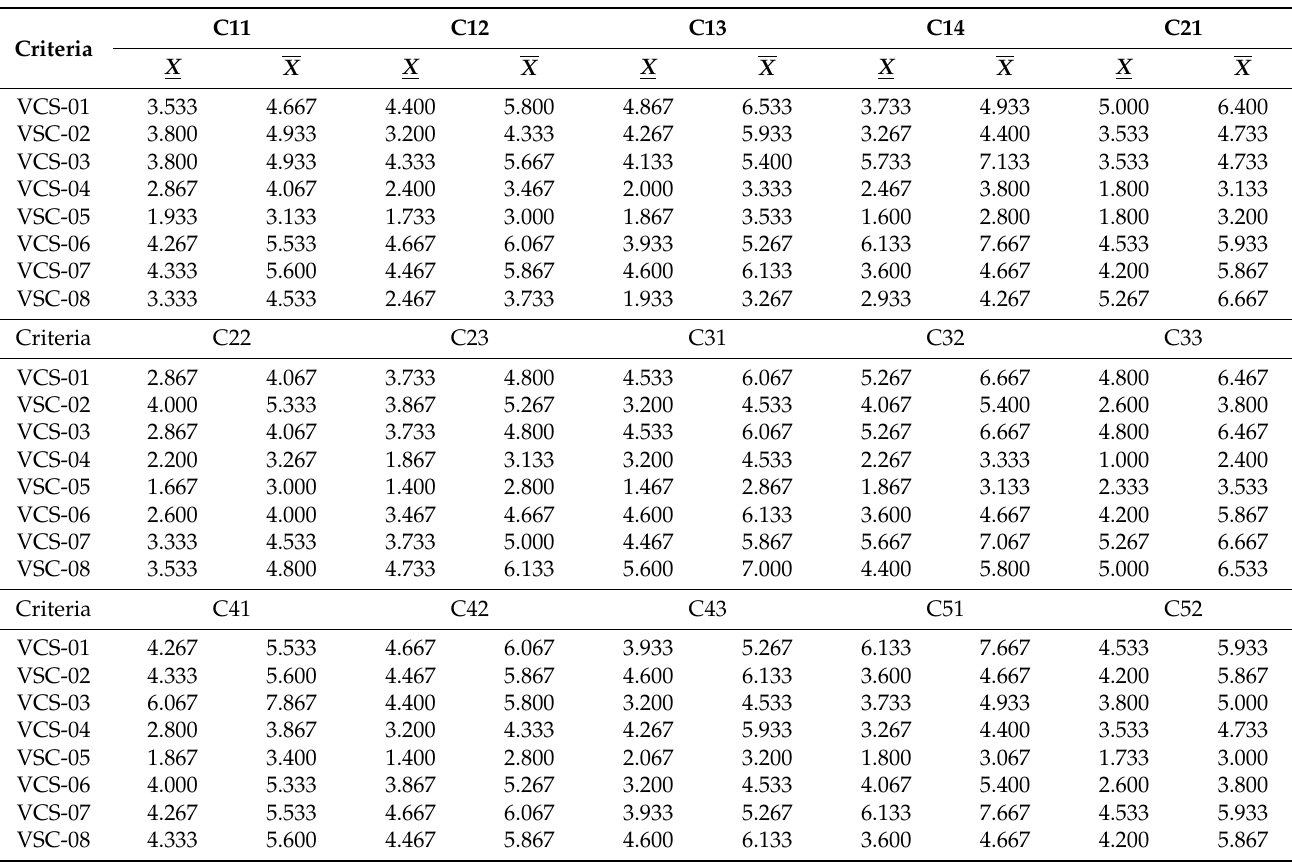
Table A2. The integrated grey decision matrix of